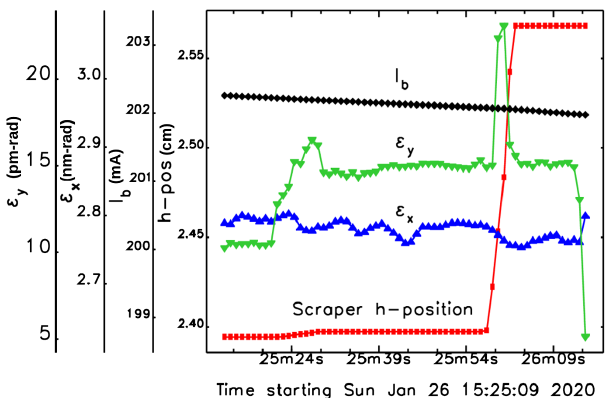
FIG. 15. Beam emittances, scraper position, and beam current for a 200-mA beam with a 2.6 mm vertical bump. The plot ends with the beam